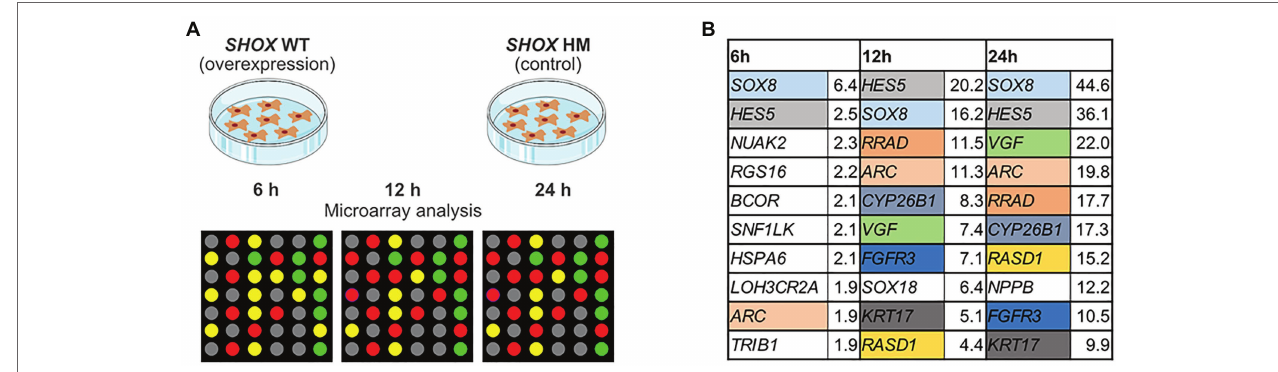
FIGURE 1 | Microarray analysis of SHOX overexpressing wild type (WT) and mutant (HM) normal human dermal fibroblast (NHDF) cells. (A) Overview of experimental design. (B) Top 10 regulated genes in SHOX overexpressing NHDF cells after 6, 12, and 24 h. Identical colors indicate the same genes at different time points. Relative expression ratios are indicated next to the gene’s name.